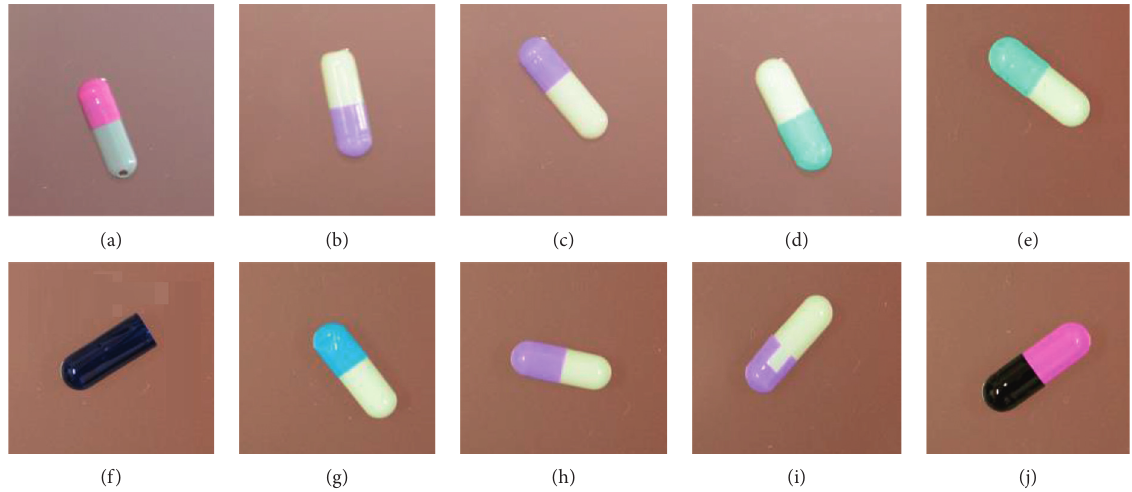
Figure 2: Physical images of the defective capsules. (a) Hole, (b) concave head, (c) uncut body, (d) oil stain, (e) short body, (f) insertion, (g) shriveled, (h) locking, (i) nesting, and (j) normal.